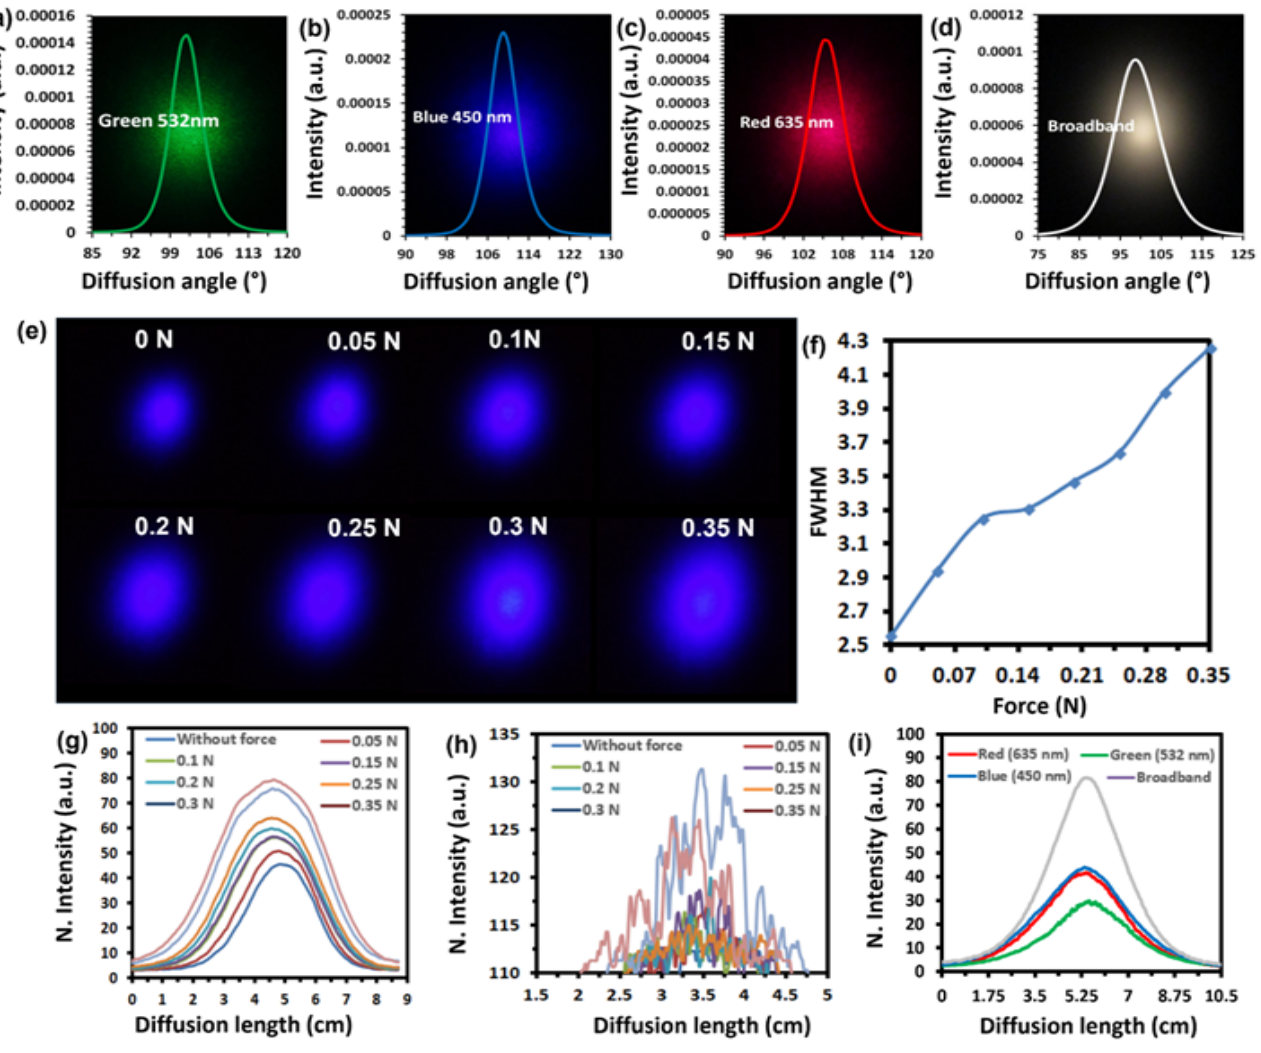
Figure 2. Optical characterization of replicated polymerized diffuser samples. ( a – d ) Light intensity distribution profiles of samples in response to three monochromatic lasers (450 nm, 532 nm, and 650 nm) lights and broadband (white light) sources. ( e ) The optical images of the diffusion field